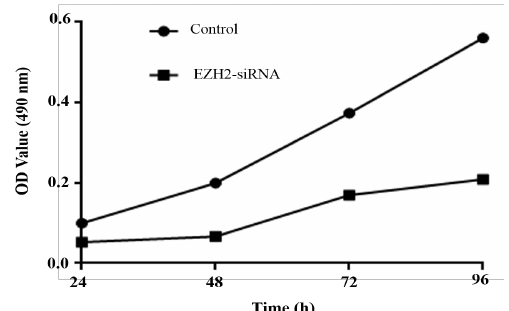
Fig. 2. Downregulation of EZH2 expression inhibits the proliferation of CRC cell line (P <0.05). Curves of HCT116 cells growth were showed at 24, 48 and 72 h after EZH2-shRNA transduction by MTT